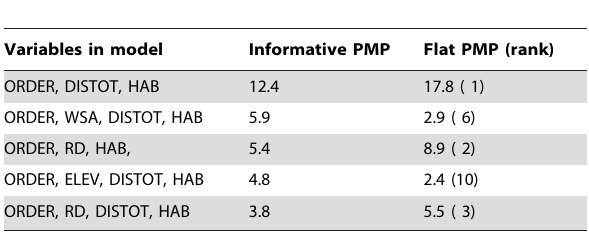
Table 5. Model selection results for the fish tolerance data set.